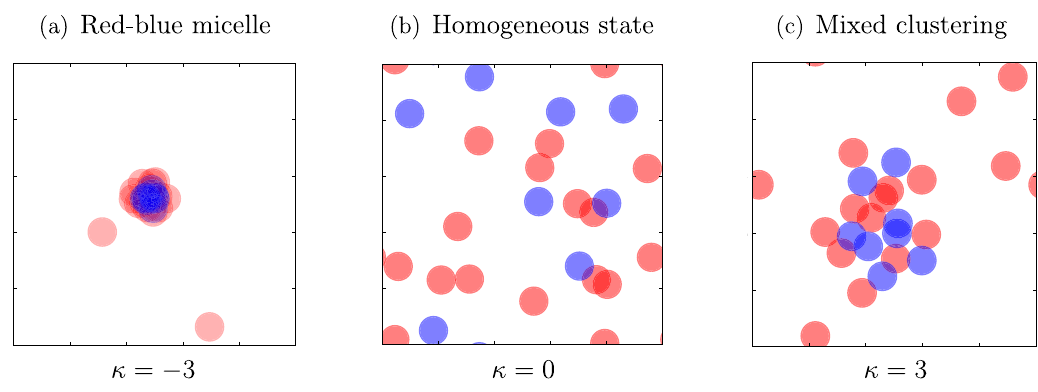
FIG. 6. Configurations obtained from a direct sampling of the biased ensemble where the pair interactions between red and blue particles are selectively modified. In the unbiased dynamics ( κ ¼ 0 ), interactions are purely repulsive with a soft core which has a similar strength for all particles, either red or blue, so that the system is homogeneous. The dynamical bias promotes clustering for both signs of κ , yet it changes interaction selectively for either sign. The repulsion is increased between red and blue particles for κ ¼ 3 , and their interactions become effectively attractive for κ ¼ − 3 . As a result, the clusters which emerge spontaneously have different structures: either a random composition of mixed reds and blues ( κ ¼ 3 ) or a micellelike structure with a blue core ( κ ¼ − 3 ). This result illustrates how biasing specific pairs leads to supervised spatial organization. Simulation details are in Appendix A and movies in Ref.